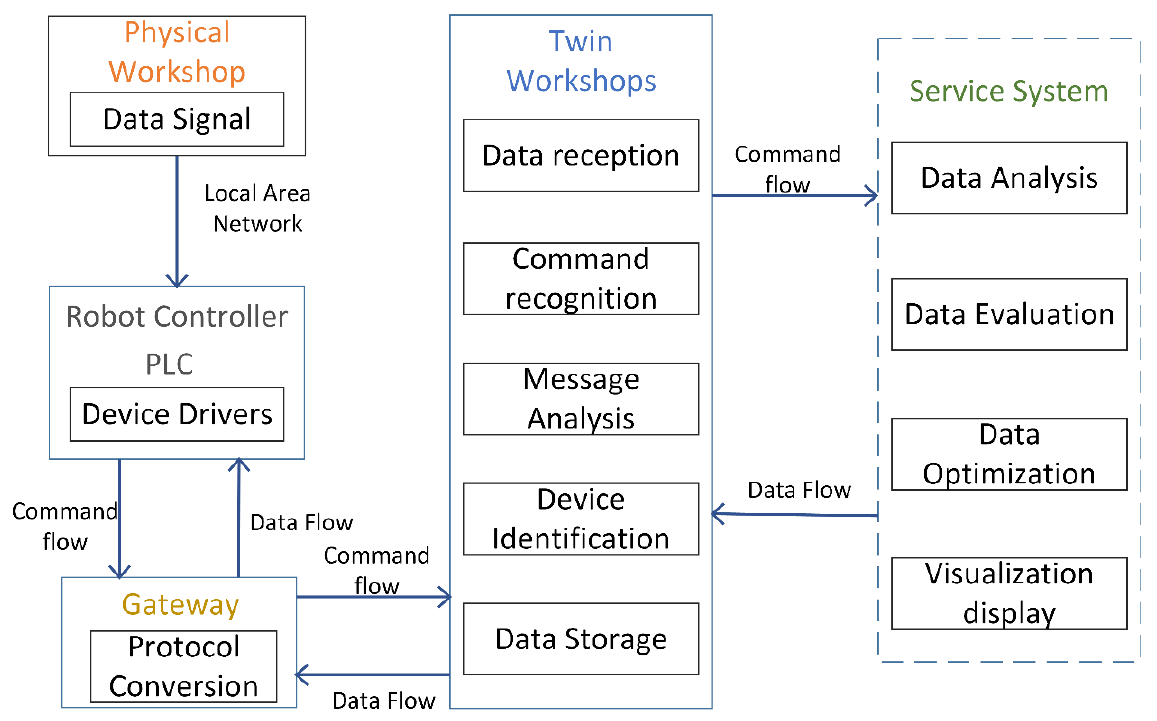
Figure 7. Data communication flow.